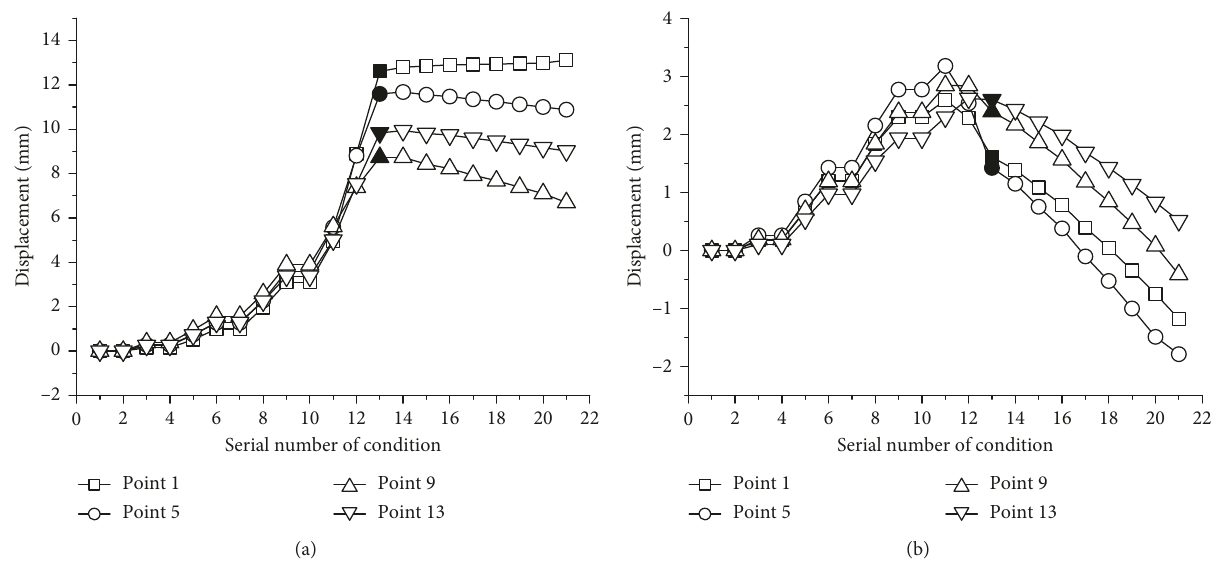
Figure 11: Time history of displacement of the tunnel in Scheme 3. (a) Horizontal displacement. (b) Vertical displacement.